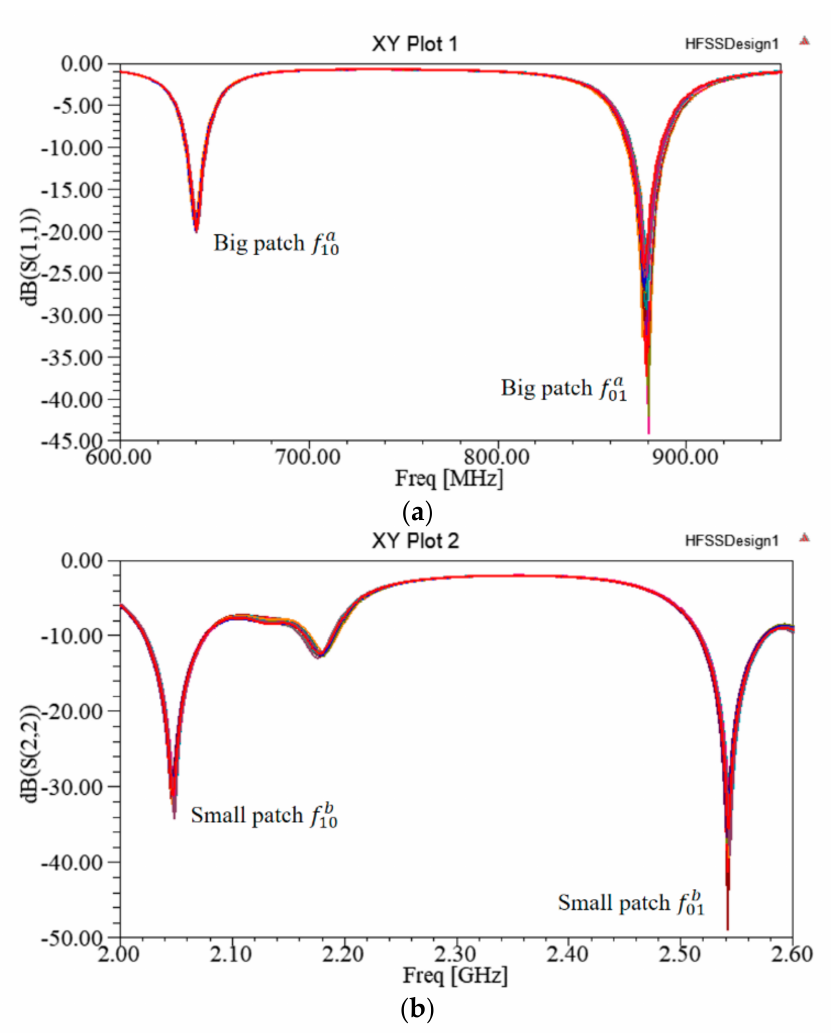
Figure 7. Working resonant frequencies of each layer when the substrate thickness is 1 mm; ( a ) lower patch resonant frequency (with different feeding structure to upper layer); ( b ) upper patch resonant frequency (with different feeding structure to lower